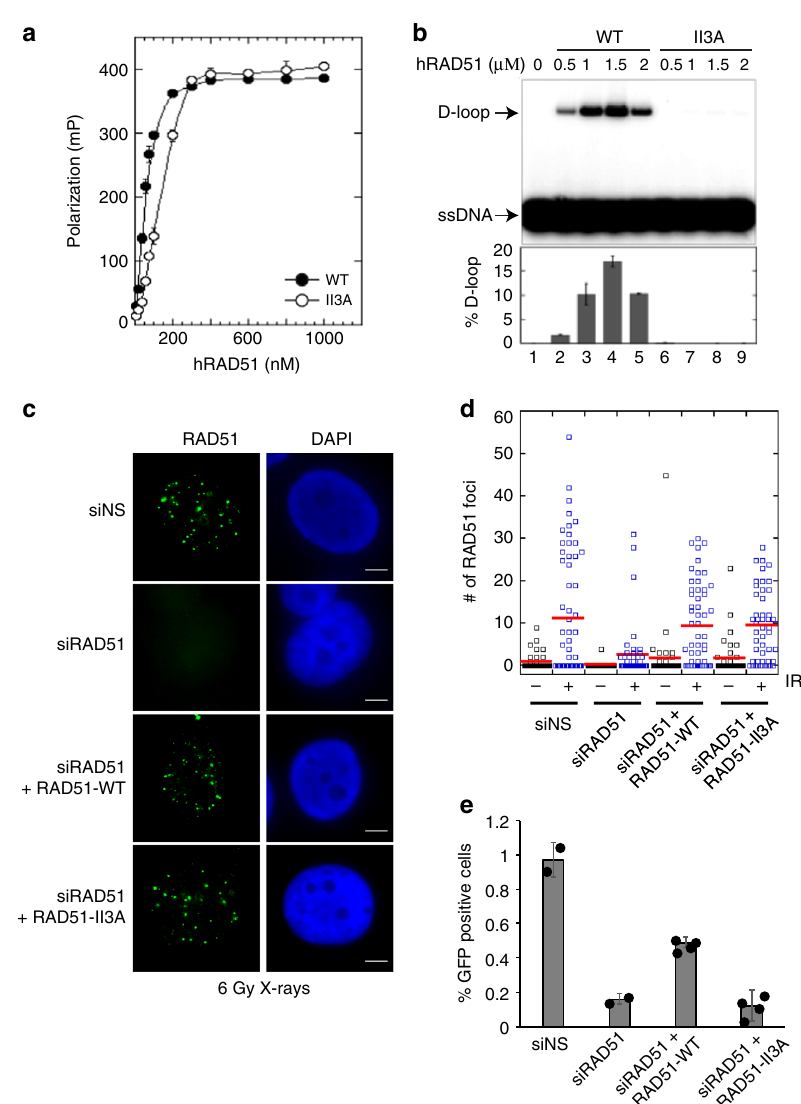
Fig. 1 hsRAD51-II3A retains ssDNA binding activity, but is defective for HR. a Human RAD51 binding to ssDNA was determined by fl uorescence polarization. Protein at various concentrations was incubated with fl uorescein-tagged 84-mer ssDNA (200 nM nucleotides or 2.4 nM molecules) in buffer B and incubated at 37 °C for 30 min. Error bars represent standard error of the mean from triplicate experiments. The apparent K d for hsRAD51-WT is 57 ± 1 nM, for hsRAD51-II3A is 132 ± 5 nM. b The D-loop activity of hsRAD51-WT and hsRAD51-II3A was measured in the presence of increasing concentrations of protein. Upper panel: autoradiogram following electrophoretic separation of D-loops from free 32 P-labeled ssDNA oligo substrate. Lower panel: quantitation of the autoradiogram shown in the upper panel. Error bars represent standard error of the mean from triplicate experiments. c Images depict immunostaining RAD51 in cells prepared for staining 8 h after a dose of 6 GY X-rays in the indicated samples. Green-RAD51 Blue-DNA. Scale bar = 5 μ m. d Quantitation of RAD51 foci after the indicated treatments. Red line represents the mean. N = 50 nuclei from two independent experiments. Values are presented as mean ± STD. Statistical signi fi cance was determined using Mann – Whitney test ( e ) DR-GFP assay. The percentage of GFP-positive cells in each sample are graphed. Graph is the average from two independent experiments. hsRAD51-WT and hsRAD51-II3A samples were done in duplicate for both experiments. Error bars represent standard deviation and values are presented as mean ± SD. Statistical signi fi cance was determined using t test. Source data are provided as a source data fi